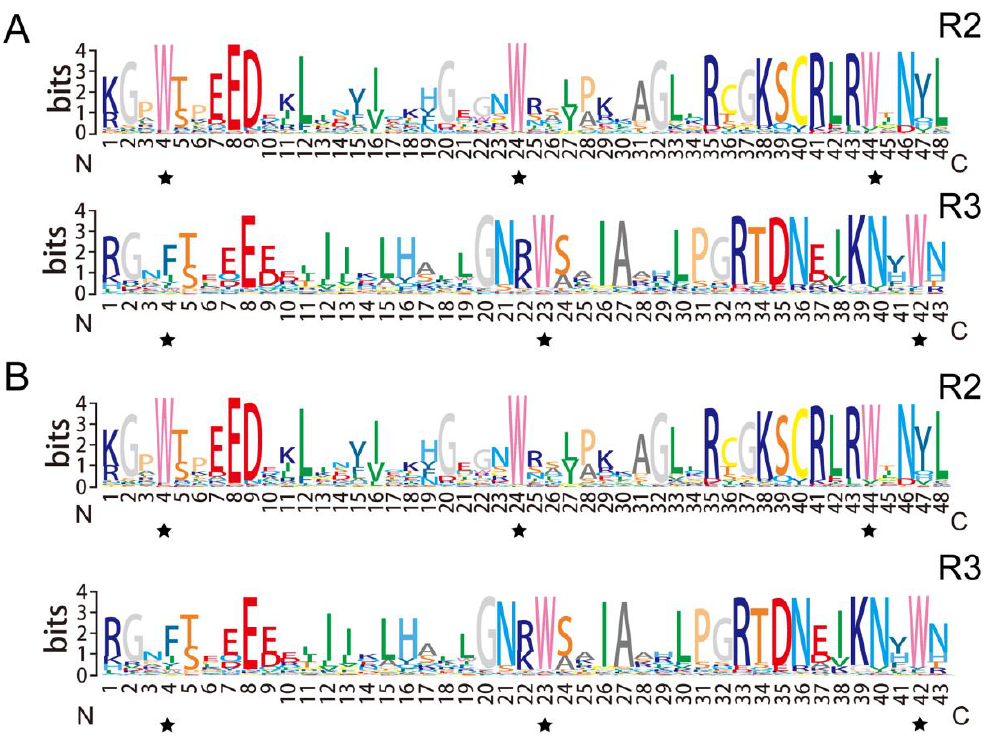
Figure 1. Sequence logos of the R2 and R3 MYB repeats of MYB members from potato ( A ) and Arabidopsis ( B ). The results were generated by multiple alignment analysis of Arabidopsis and potato R2R3-MYB members and visualized by Texshade. The asterisks indicate the typical conserved Trp residues in the MYB domain.